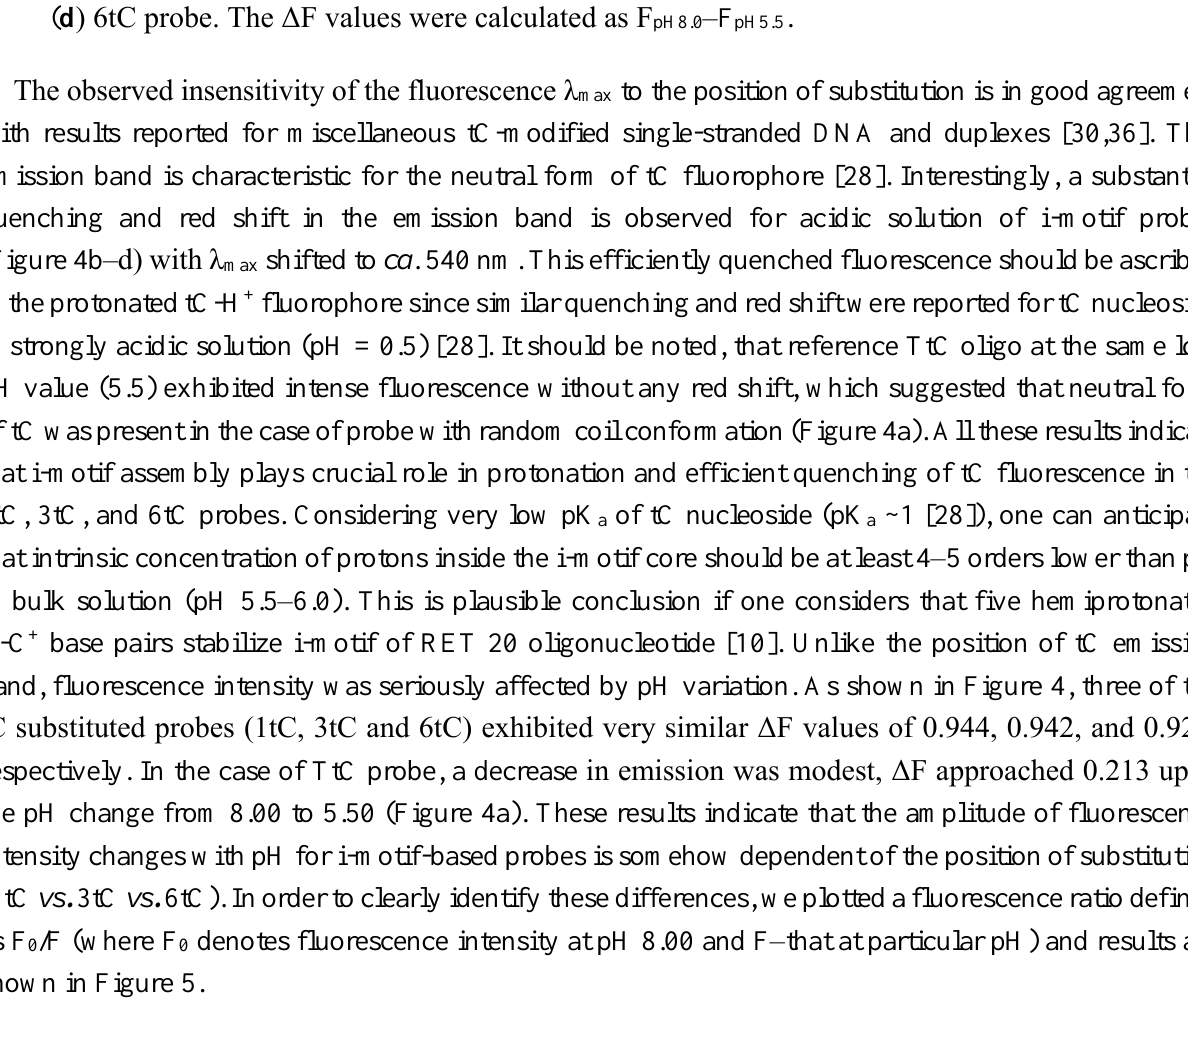
Figure 4. The emission spectra of tC-based probes recorded at room temperature at the pH range from 5.50 to 8.00 with λ ex = 395 nm: ( a ) TtC probe, ( b ) 1tC probe, ( c ) 3tC probe and ( d ) 6tC probe. The ΔF values were calculated as F pH8.0 –F pH5.5